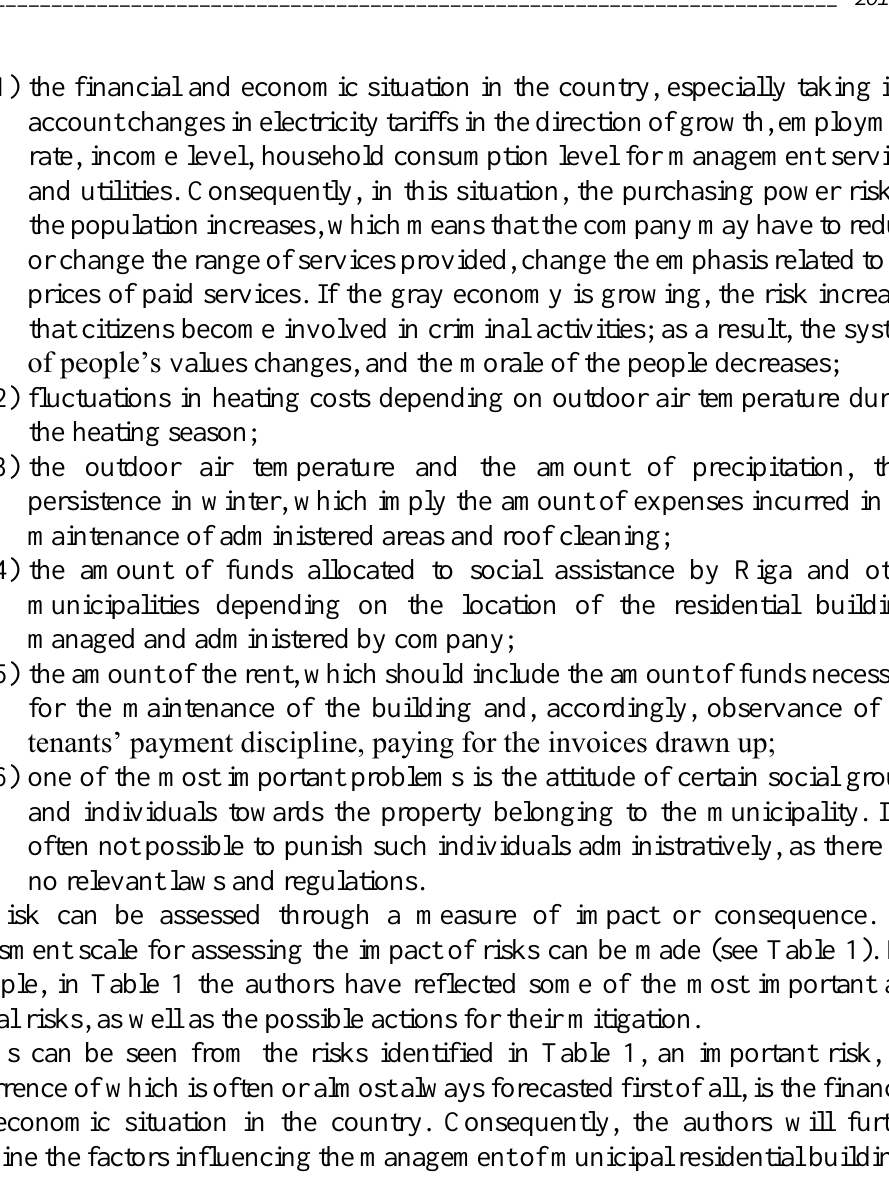
Table 1. Risk Assessment Matrix (table made by the